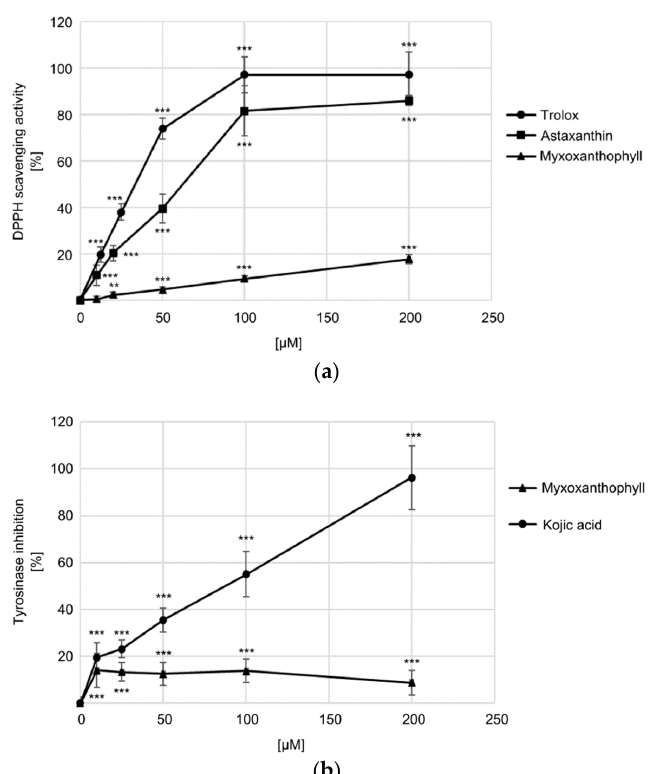
Figure 7. ( a ) The DPPH (2,2-diphenyl-1-picrylhydrazyl) free radical scavenging activity of the tested substance. Trolox and astaxanthin were used as positive controls. ( b ) Inhibition of the fungal tyrosinase by myxoxanthophyll using levodopa (L-DOPA) as a substrate. Kojic acid was used as a positive control. The data represent mean ± SD. Student’s t -test was used for the statistical analysis. ** p < 0.01, *** p < 0.001 related to control.